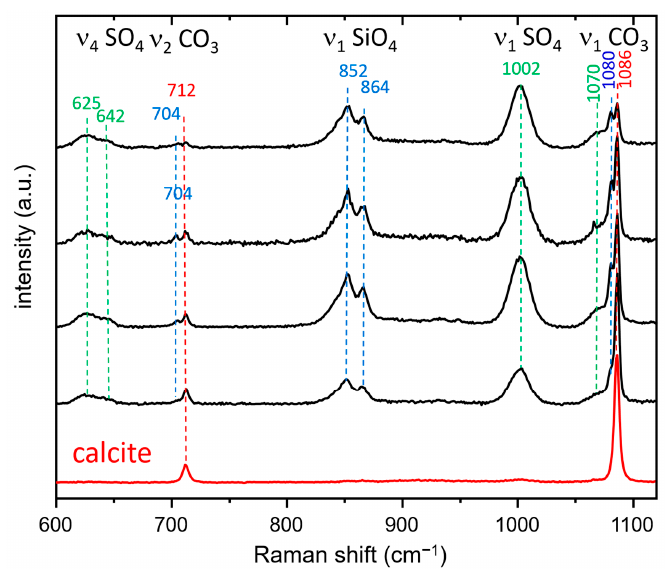
Figure 7. Raman spectra at different spots of the sample HT[D2]_800 showing different degrees of intermixing of calcite (bottom), spurrite, and ellestadite. The bands due to the ν 1 CO 3 vibration of calcite (1086 cm − 1 ), spurrite (1080 cm − 1 ), and ellestadite (1070 cm − 1 ), can be clearly distinguished. Figure 8 is representative for all possible variations of mixtures between ellestadite and spurrite observed in the spectra of sample HT[D2]_800. Samples calcined at that tem- perature contain mainly intermediate products such as spurrite, ellestadite, and unreacted SiO 2 , CaCO 3 , and lime, according to XRD. At this temperature stage, the phases are strongly intermixed and the acquisition of Raman spectra of single phases was relatively difficult. This is also reflected in Figure 7, which shows spectra of pure calcite and mix- tures of calcite with spurrite and ellestadite.